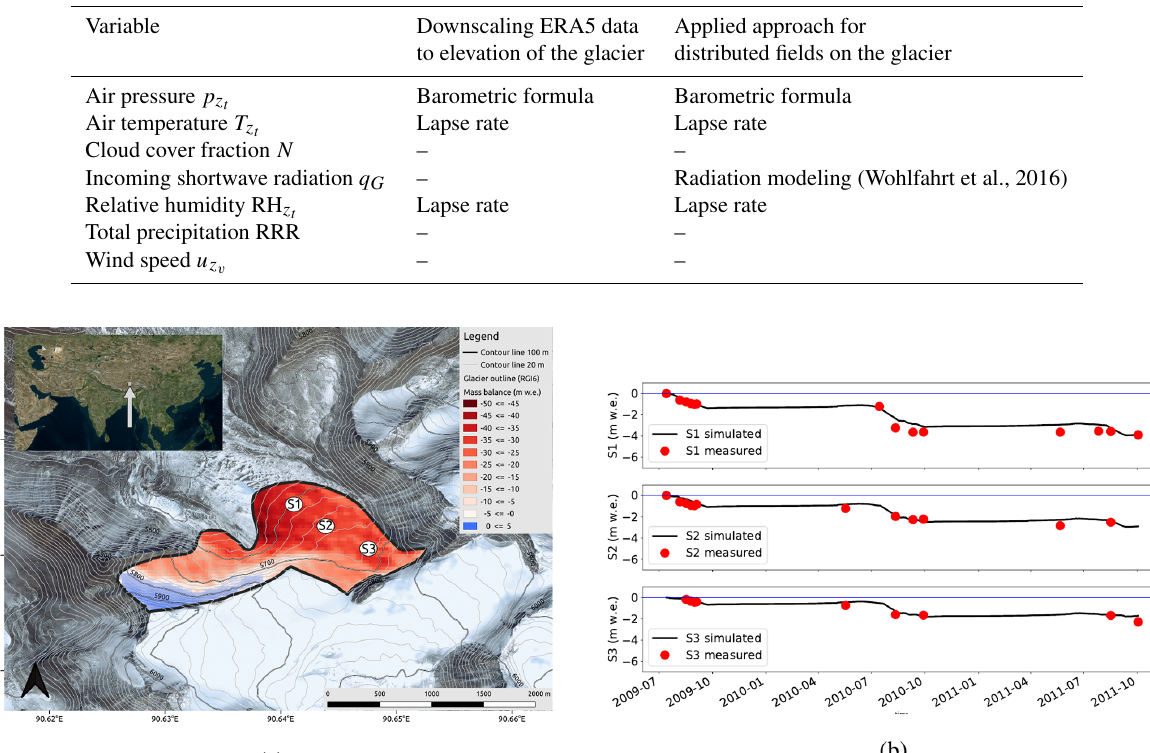
Figure 2. Distributed mass balance simulation of the Zhadang glacier. (a) Cumulative climatic mass balance from 2009 to 2018 with 1827 grid points, contour lines (SRTM), glacier outline from the Randolph Glacier Inventory 6.0, and a topographic map from Bing Maps (Microsoft, 2020); (b) comparison of three measurements (ablation stakes) from July 2009 to October 2011 with the simulated cumulative surface mass balance of the corresponding grid point.